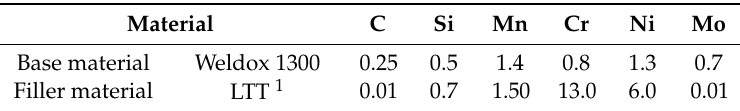
Table 1. Chemical compositions of base and filler materials (wt. %).